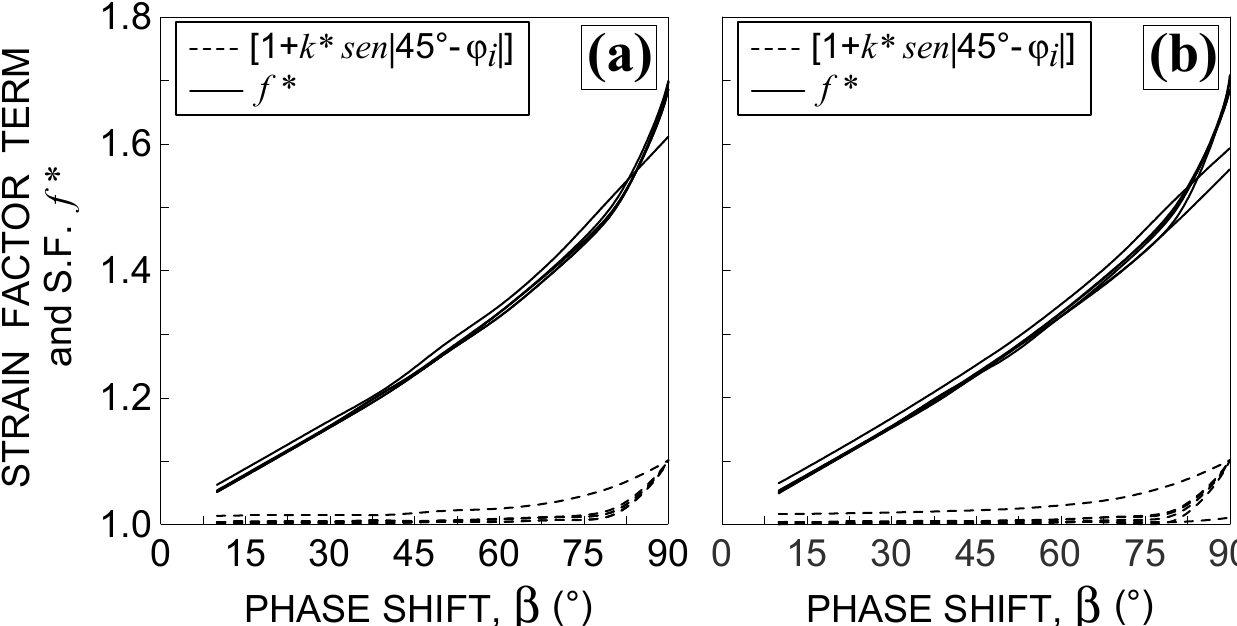
β β ° ≤ ≤ ° Figure 9. Influence of the phase shift ( 10 90 ) on both the 1st term of the strain factor * f (see Equation Materials 2021 , 14 , x FOR PEER REVIEW Figure 9. Influence of the phase shift β ( 10 ◦ ≤ β ≤ 90 ◦ ) on both the 1st term of the strain factor f ∗ (see Equation (16)) and (16)) and * f for the non-proportional loading conditions: ( a ) Nos.7–12 and ( b ) Nos.13–18, in Table 2. f ∗ for the non-proportional loading conditions: ( a ) Nos. 7–12 and ( b ) Nos. 13–18, in Table 2.